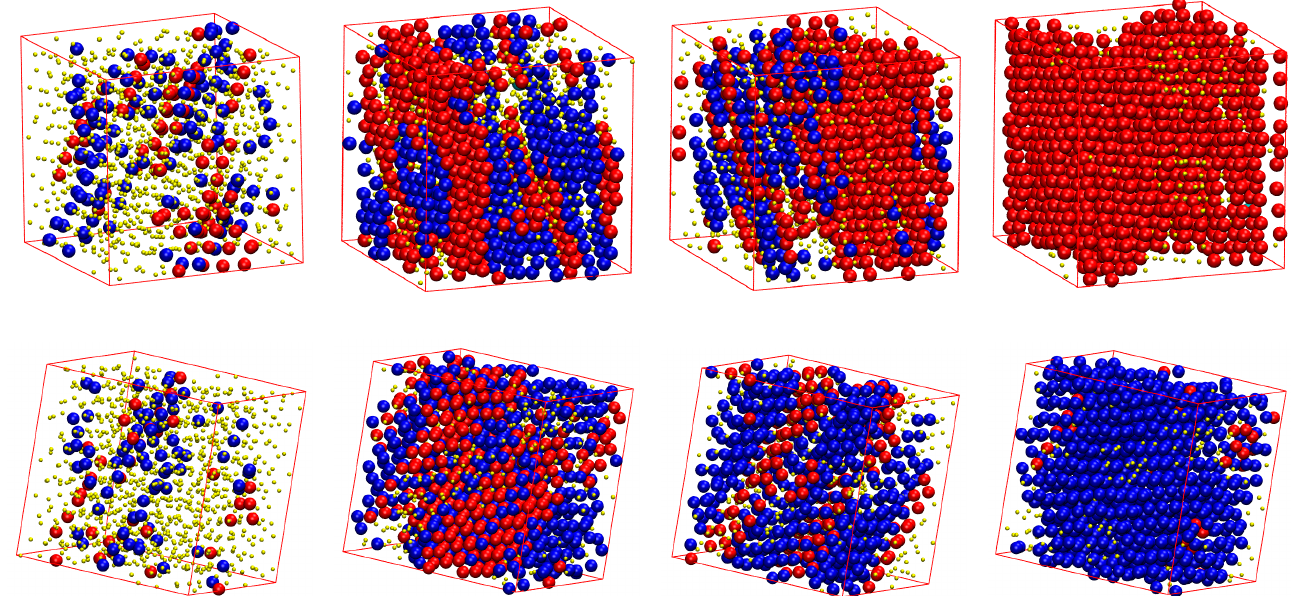
Figure 9. Computer-generated representations of the crystal growth of the 100-chains N av = 12 semi- flexible system chains with bending constant k θ = 9 and equilibrium bending angle θ 0 = 0 ◦ at ( top ) ϕ = 0.58 after (from left to right) 1, 25, 60 and 100 × 10 8 MC steps, and at ( bottom ) ϕ = 0.60 after (from left to right) 1, 240, 300 and 350 × 10 8 MC steps. Monomers are color-coded according to CCE norm. Blue, red, and green correspond to HCP-, FCC-, and FIV-like sites, respectively. Amorphous (AMO) sites are colored yellow. For visual clarity, monomers are shown with reduced dimensions. Individual panels are also available as stand-alone, interactive, 3-D images (in Supplementary Ma- terials).